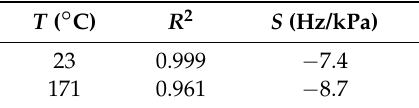
Figure 6. Resonance frequency shift ( ∆ f ) plotted with respect to the differential pressure ( p ) at 23 °C and 171 °C. The frequency shift was calculated accordingly to the starting point which is the resonance frequency at 0 kPa. Table 2. Sensitivity ( S ) and linear regression factor R 2 for measurements at 23 °C and 171 °C. The values were evaluated after fitting the frequency shift data with the linear curve (see Figure 6).